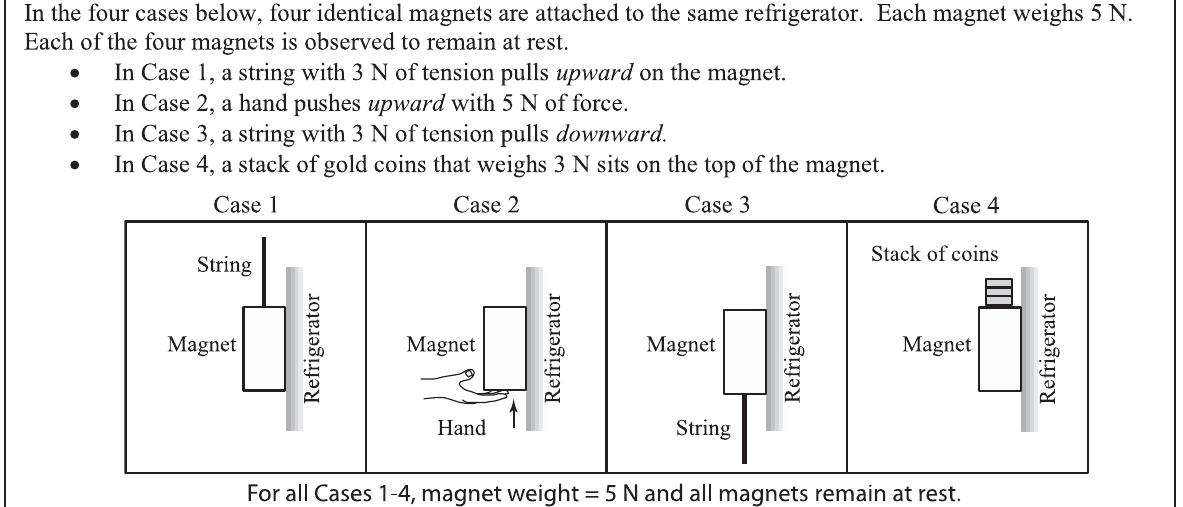
FIG. 6. The post-test question.